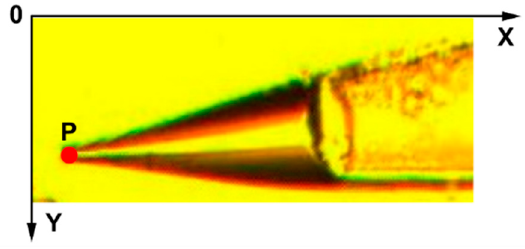
Figure 8. The coordinate system of the image.